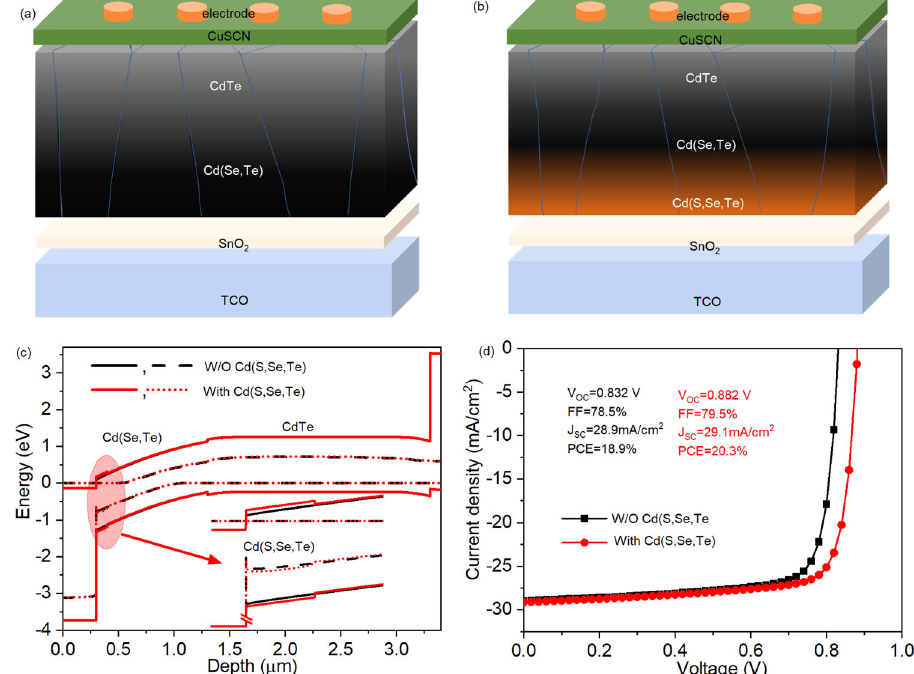
Fig.1| Bene fi tsofthebandgapgradientatthefrontjunction. Con fi gurationsof devices ( a ) without and ( b ) with a proposed bandgap gradient on the commercial SnO 2 buffer layer and ( c ) the corresponding band alignment of the proposed devices.Thesolidblackandredlinesarealmostcompletelyoverlappedbecauseof